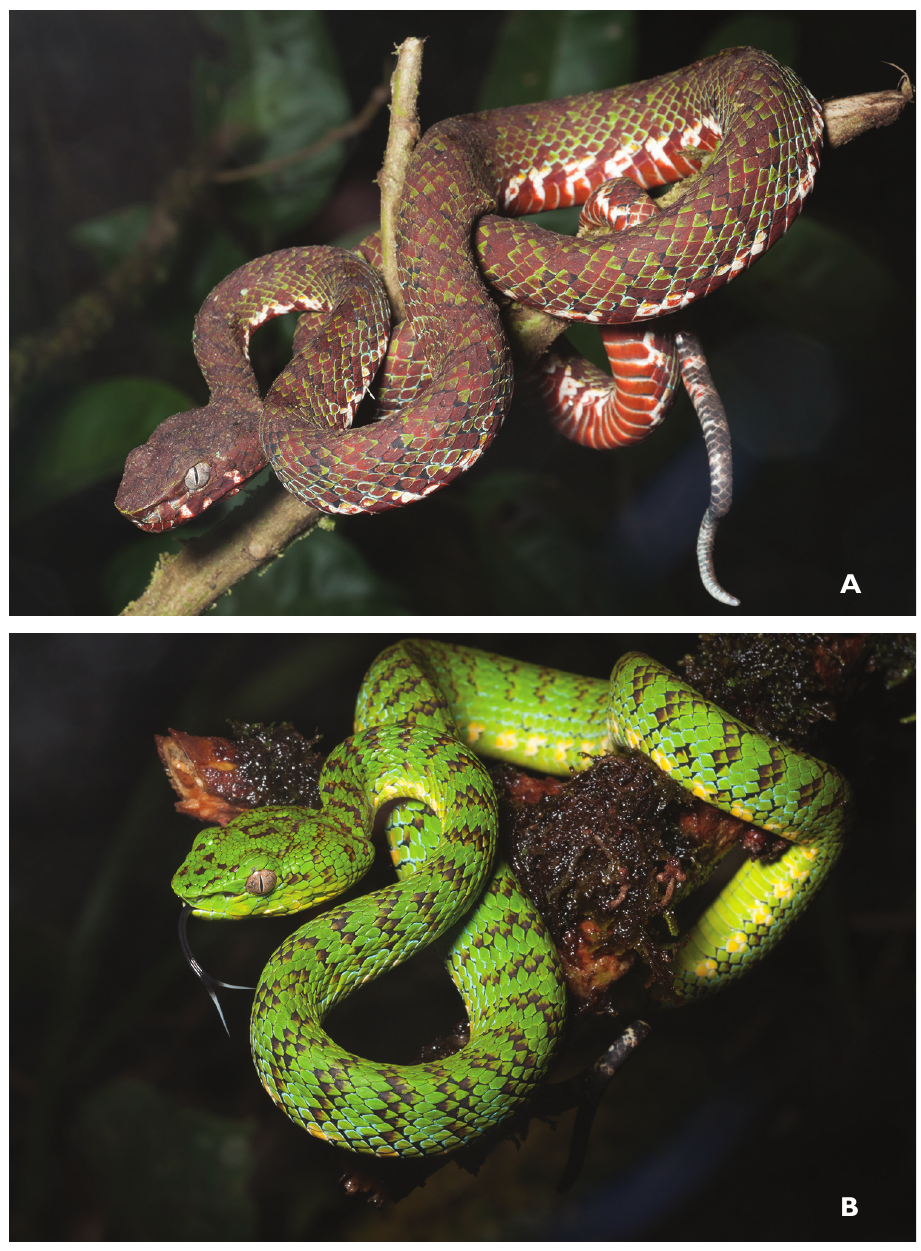
Figure 78. Trimeresurus cf. flavomaculatus red phase male ( A KU 334433), green phase male ( B KU